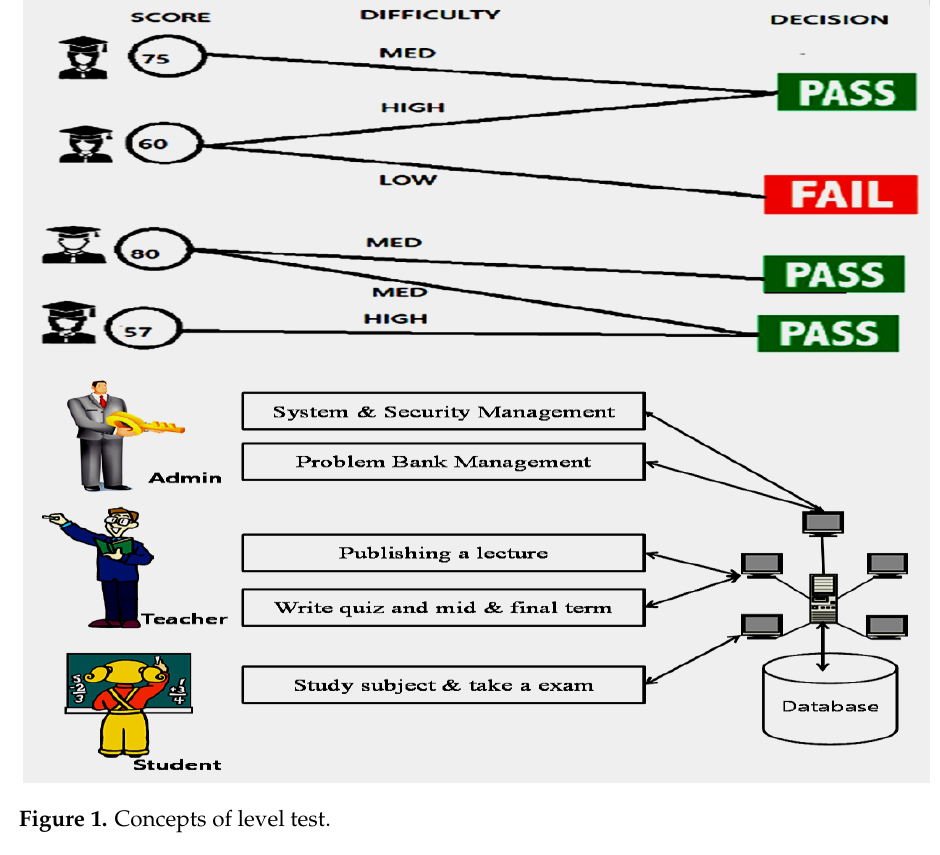
Figure 1. Concepts of level test.